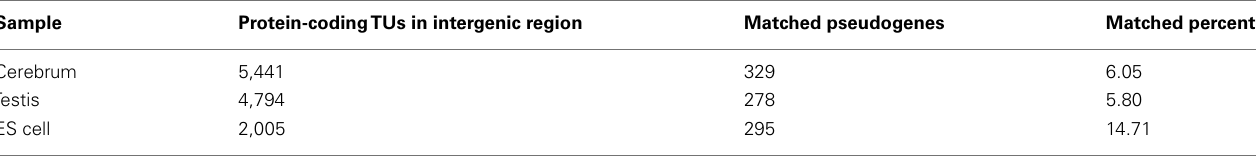
TableA7 |The pseudogenes in novel intergenicTUs.